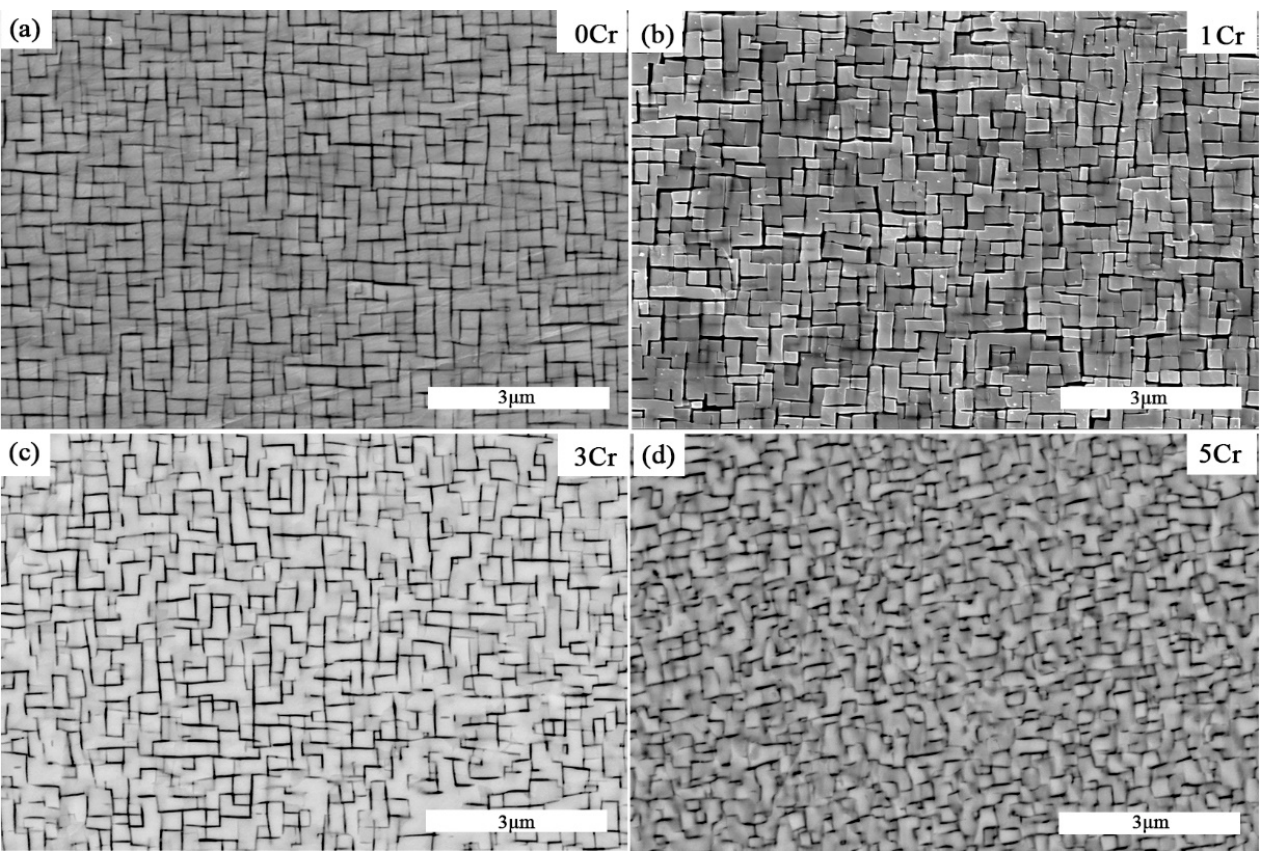
Figure 1. The SEM images of microstructures of the Co-30Ni-10Al-4W-4Ti-2Ta alloys with different Cr content after homogenization heat treatment at 1250 °C for 24 h and annealing at 900 °C for 24 h ( a ) 0Cr [24]; ( b ) 1Cr; ( c ) 3Cr; ( d )